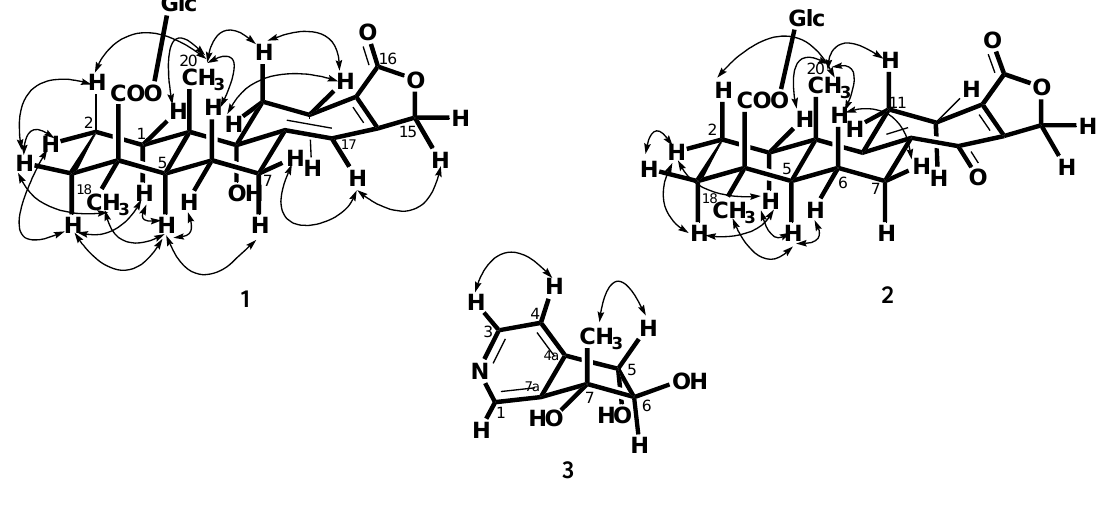
Table 2. 1 H and 13 C NMR spectral data and HMBC correlations for compound 3 in CD